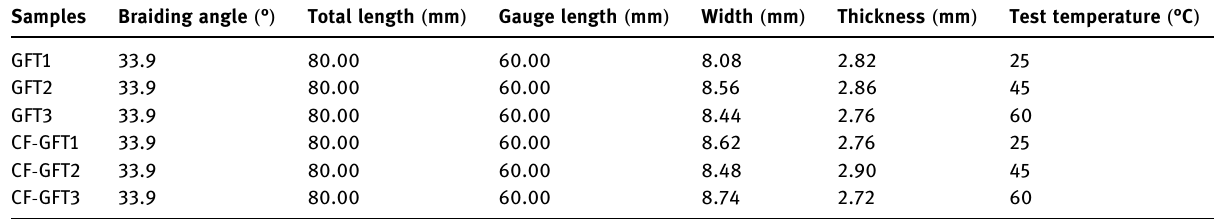
Table 1: Details of tensile samples Samples